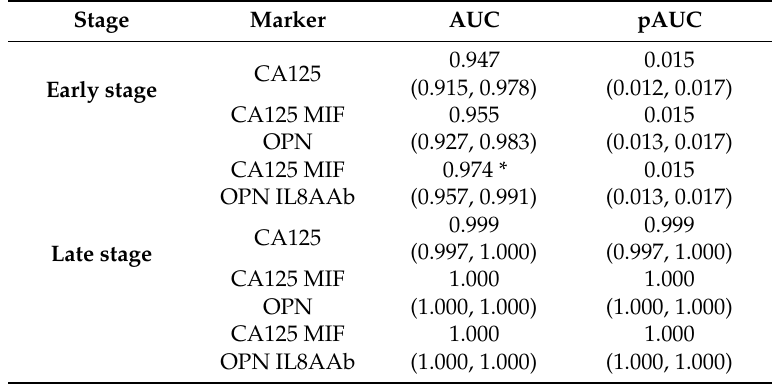
Table 3. Comparison of AUC and pAUC for biomarker models in the validation